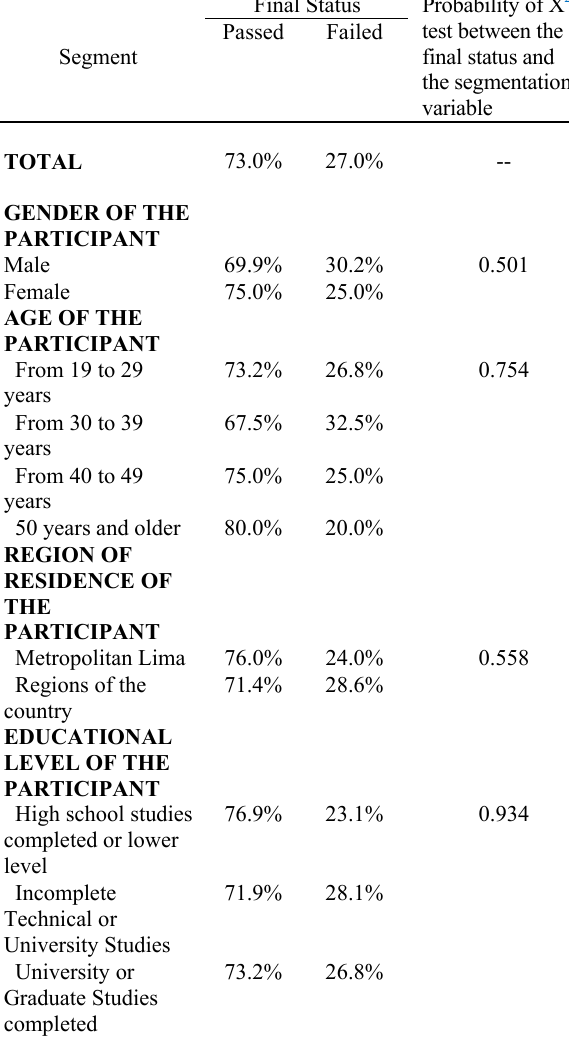
Table 1. Final Status of the participant in the Business Training Program by Segments (100% horizontal level)